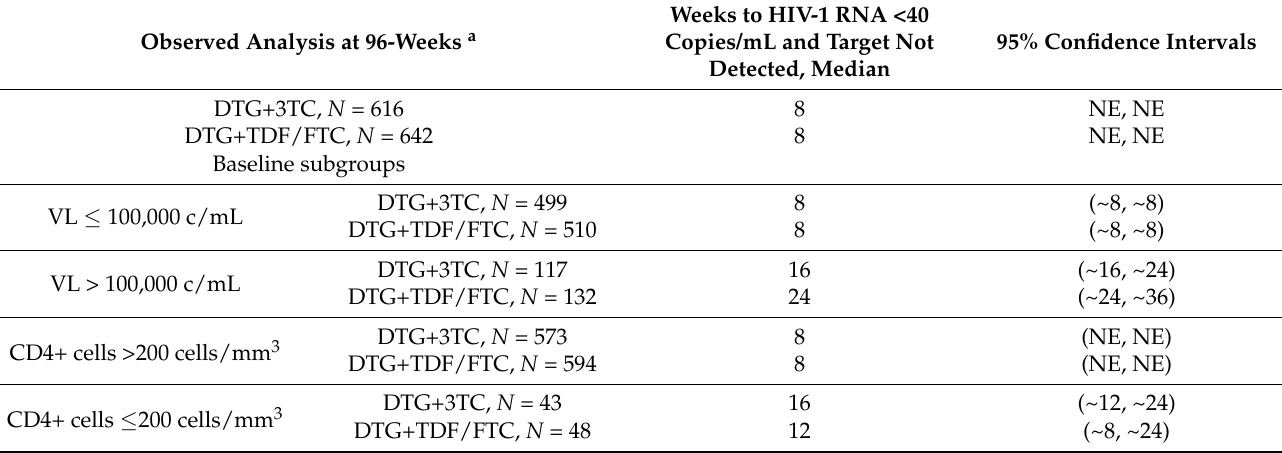
Table 3. Weeks to virological-suppression across treatment groups and baseline strata in observed analysis from GEMINI-1 and -2 clinical